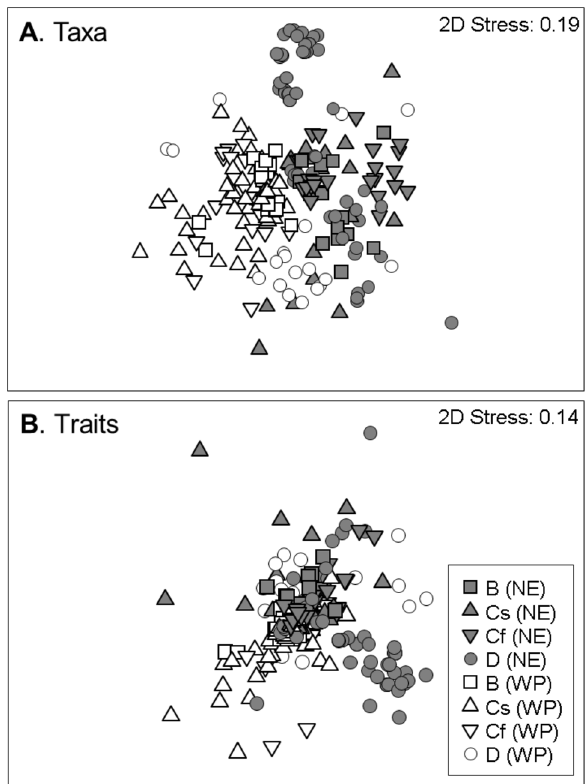
Figure 4. MDS showing sites according to their (A) taxonomic composition and (B) trait composition similarities, classified by climates (Arid, B; Temperate Harsh Summer , Cs; Temperate Mild Summer , Cf; and Cold climate, D) and ecozones (NE = Nearctic, WP = Western Palearctic).